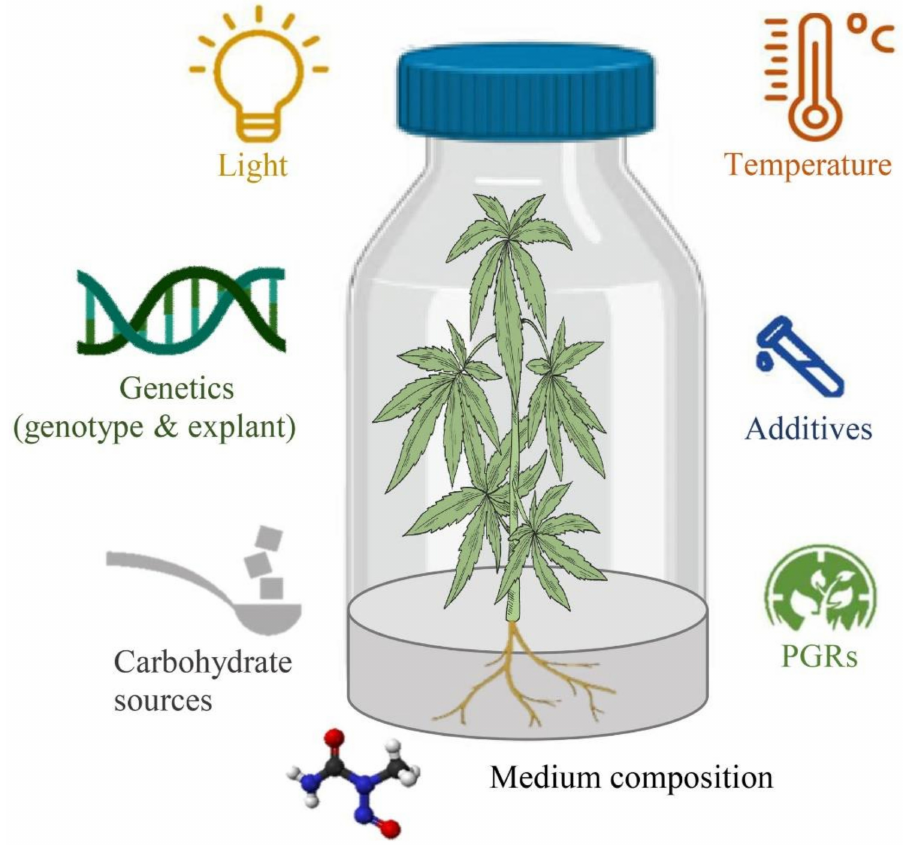
Figure 3. The schematic diagram of factors affecting in vitro culture